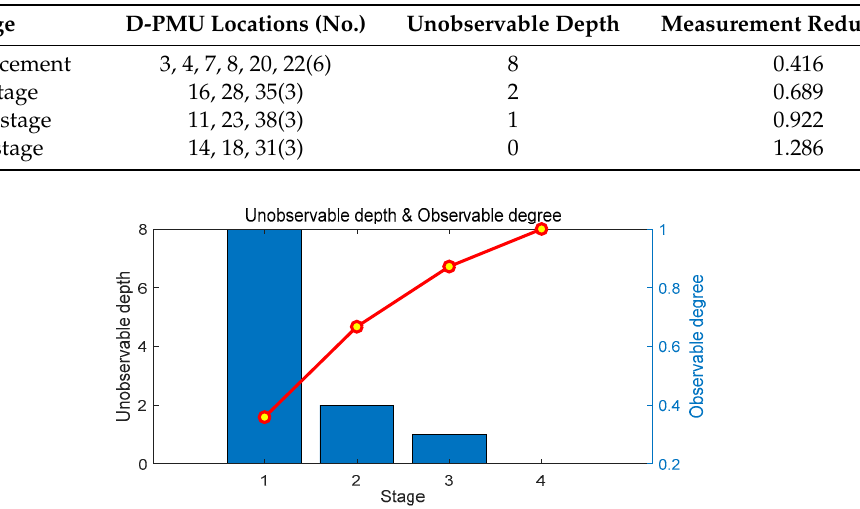
Figure 13. Unobservable depth and observable degree of theYuan'an substation.